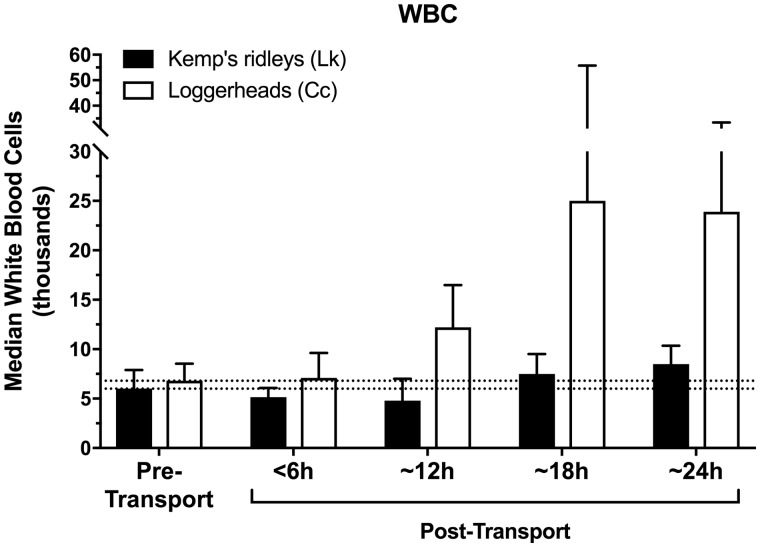
Post-transport WBC count in Kemp’s ridley and loggerhead turtles when compared with pre-transport baselines. Dashed lines indicate pre-transport medians (i.e., bars on left), for visual comparison to post-transport concentrations in both species. WBC data were not normally distributed; bars indicate median±quartiles.